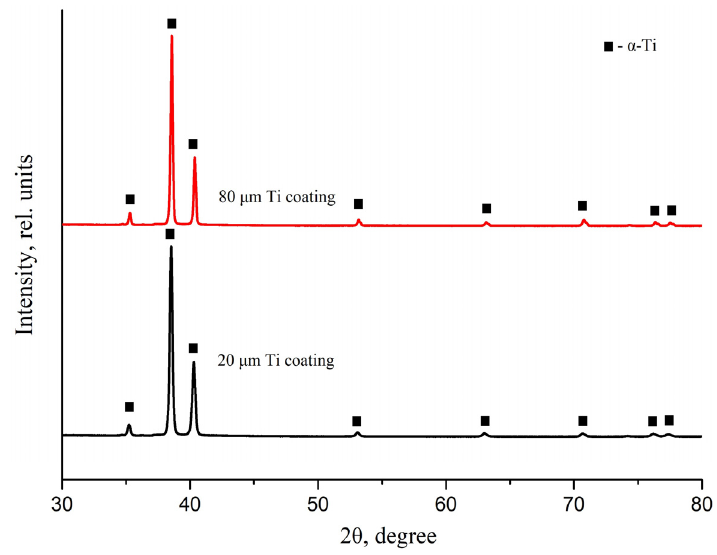
Figure 5. Diffraction patterns of the as-received Ti coatings. Figure 5. Di ff raction patterns of the as-received Ti